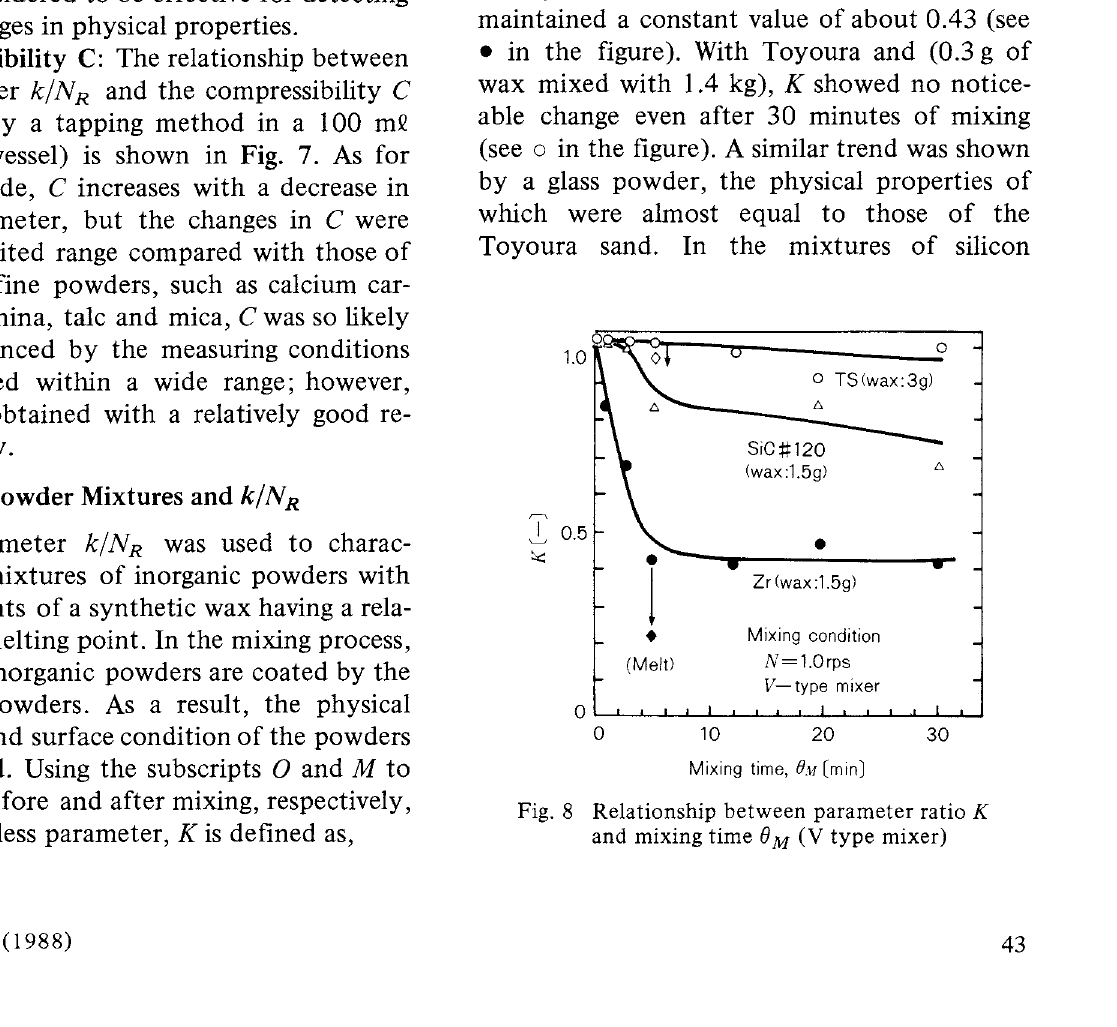
Fig. 8 Relationship between parameter ratio K and mixing time (}M (V type